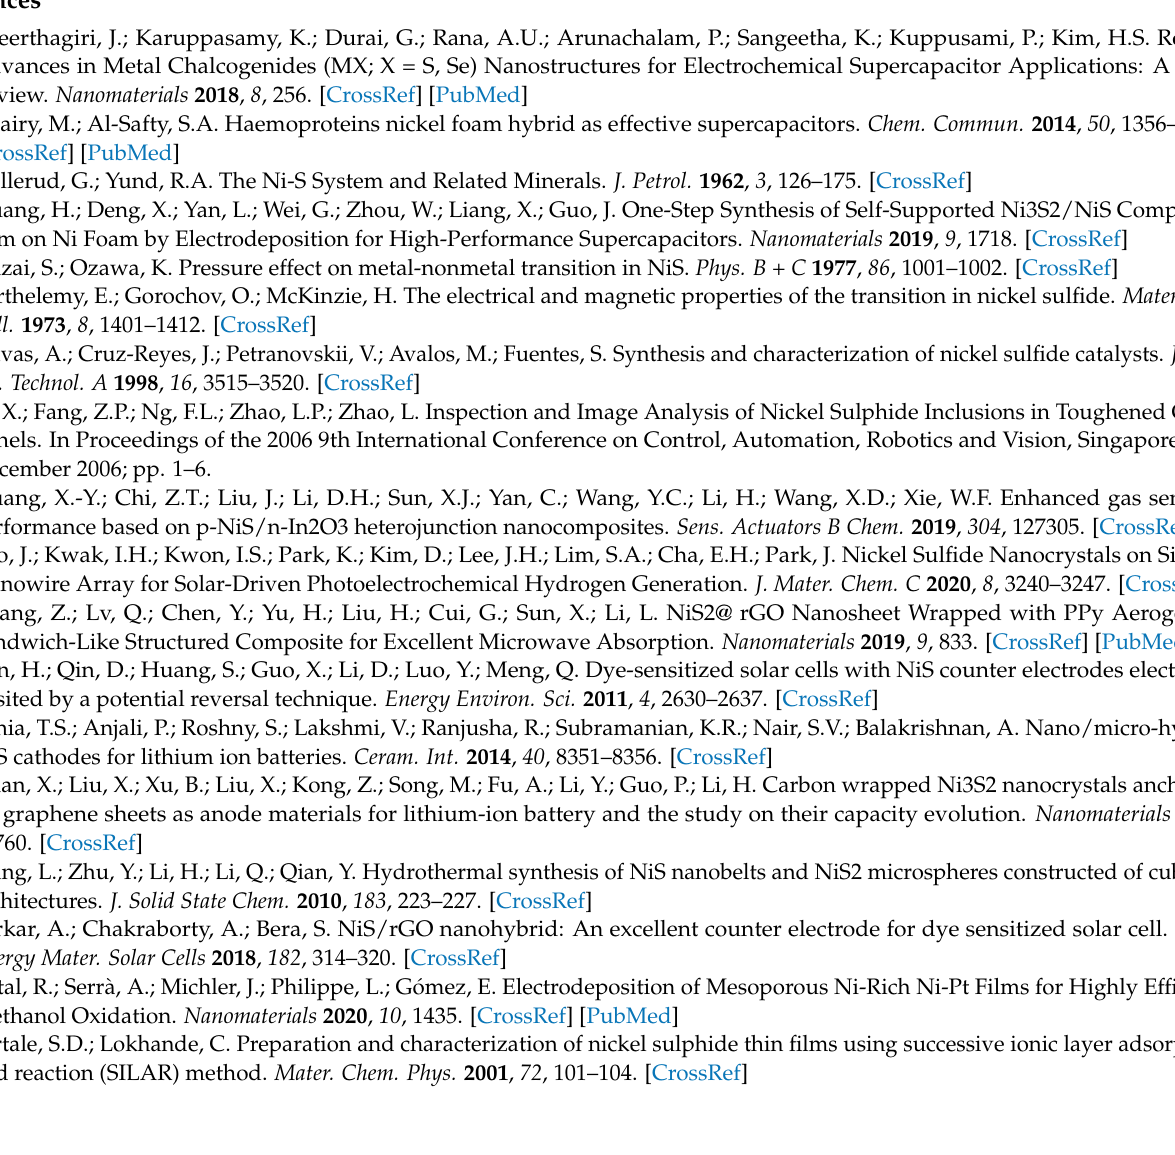
Figure S4b. EDX analysis of NiS at 450 ◦ C, Figure S5. Rietveld Refinement graphics of